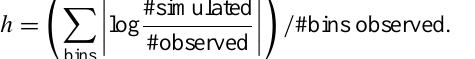
Figure 6 exposes an issue with the DMSP-F17 SSMIS ob- servations in the 50 GHz temperature sounding channels. Im- ity of a band of negative departures across the NH at 30 ◦